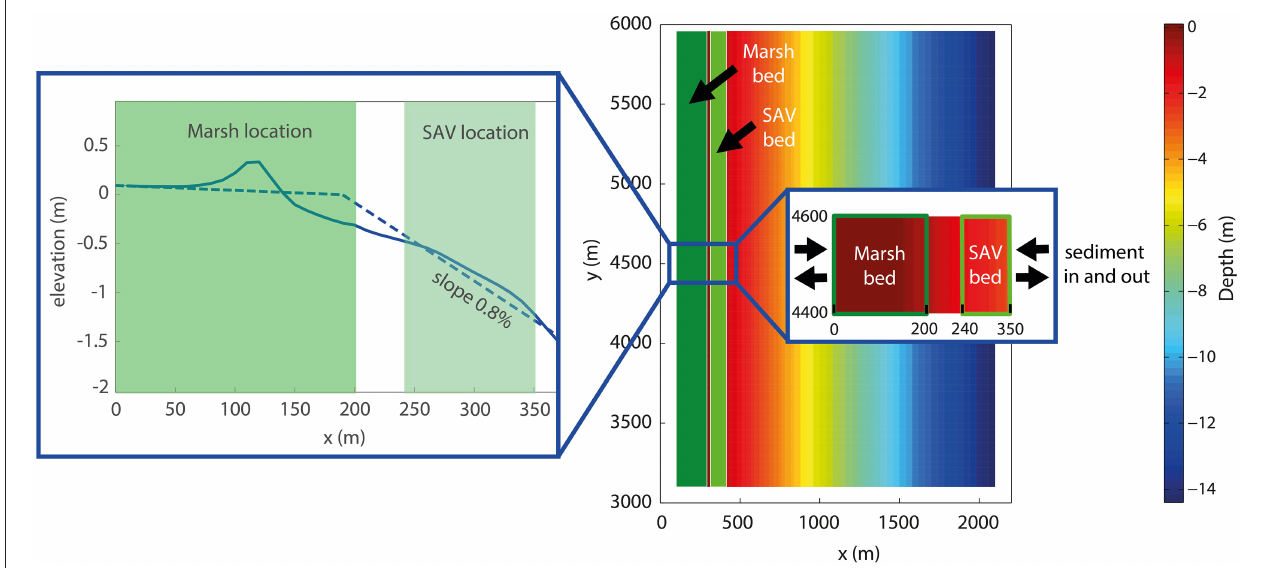
FIGURE 10 | Domain for sediment budget calculation for the scenario with basin slope